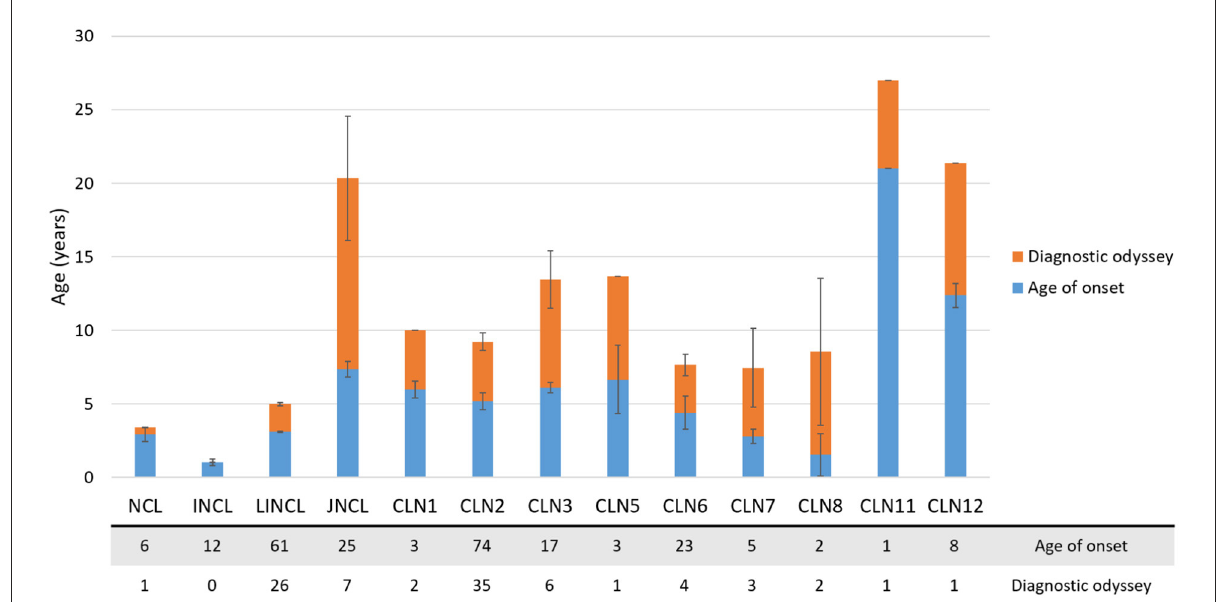
FIGURE2 Diagnostic odyssey in the SA & C cohort. Bar graph showing the age of onset (mean ± SEM, blue bars) and time to diagnosis (mean ± SEM, orange bars) in the SA & C population analyzed. The age of onset could be recorded for 240 individuals, while the age at diagnosis could only be defined for 89 individuals. The table below the graph indicates de number of individuals included in each analyzed